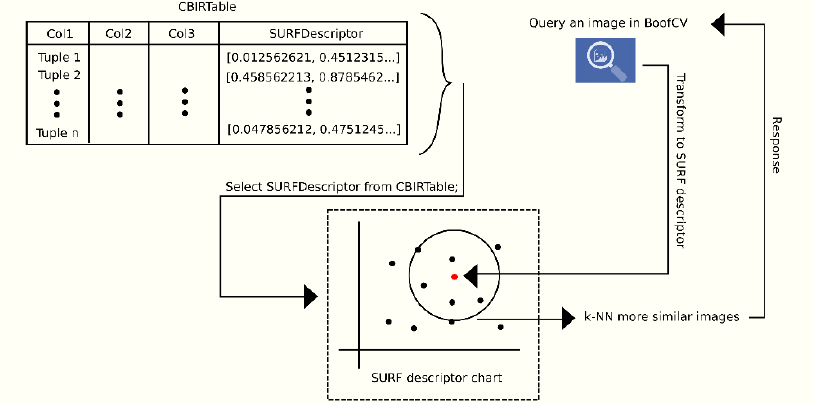
Figure 3. Process of content-based queries under the BoofCV approach.